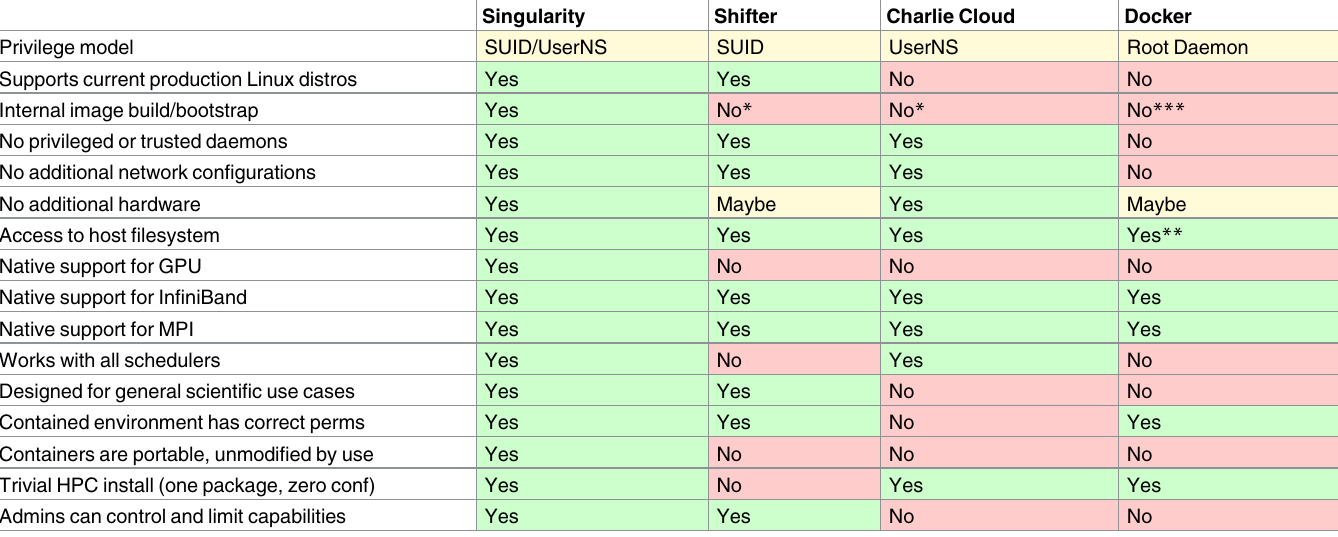
Table 1. Container